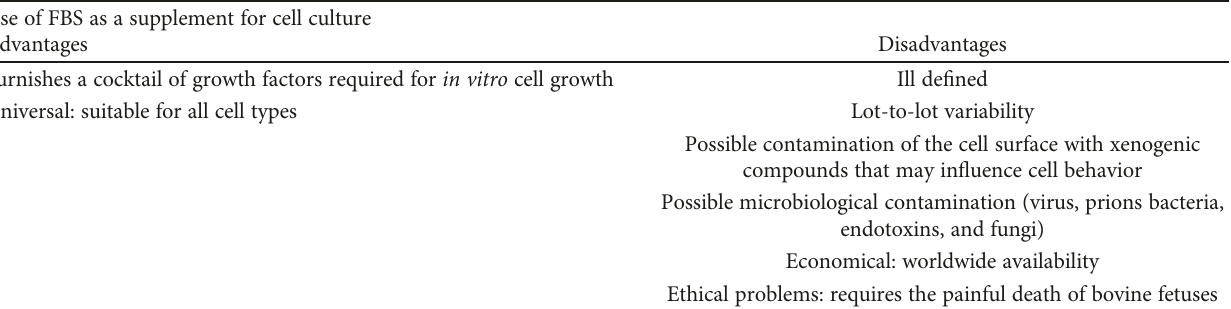
Table 2: FBS use advantages and